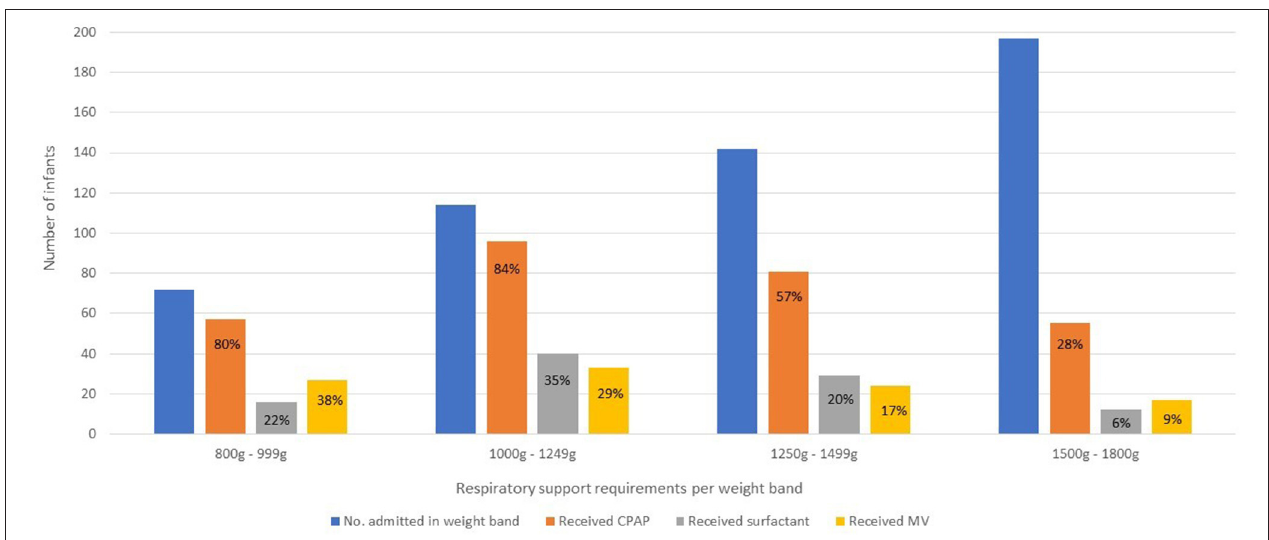
FIGURE 4 | Respiratory interventions at any time during admission stratified by weight band. Due to resource constraints, infants born < 800g are not eligible for many of the interventions usually given for RDS in well-resourced areas. However, should they survive until they are more mature, they may become eligible to receive CPAP or MV later. CPAP, continuous positive airway pressure; MV, invasive mechanical